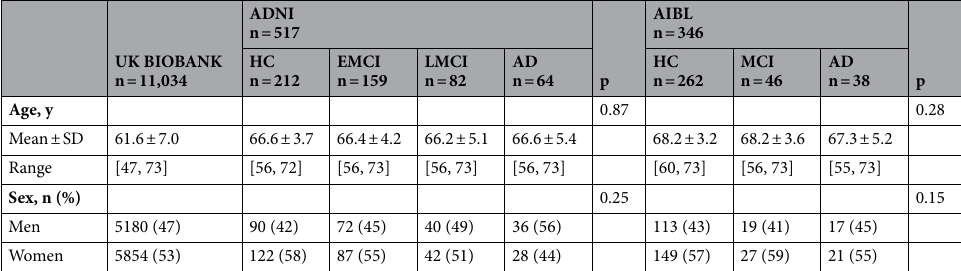
Table 1. Demographic information for the subjects from the UK Biobank dataset, the Alzheimer’s Disease Neuroimaging Initiative (ADNI) dataset, and the Australian Imaging Biomarkers and Lifestyle Study of Ageing (AIBL) dataset. We used ANOVA test and the chi ‐ square test of homogeneity to test for significant differences in age and sex between healthy controls and patients. Abbreviations: HC = healthy control; EMCI = early mild cognitive impairment; LMCI = late mild cognitive impairment; AD = Alzheimer’s disease; MCI = mild cognitive impairment; SD = standard